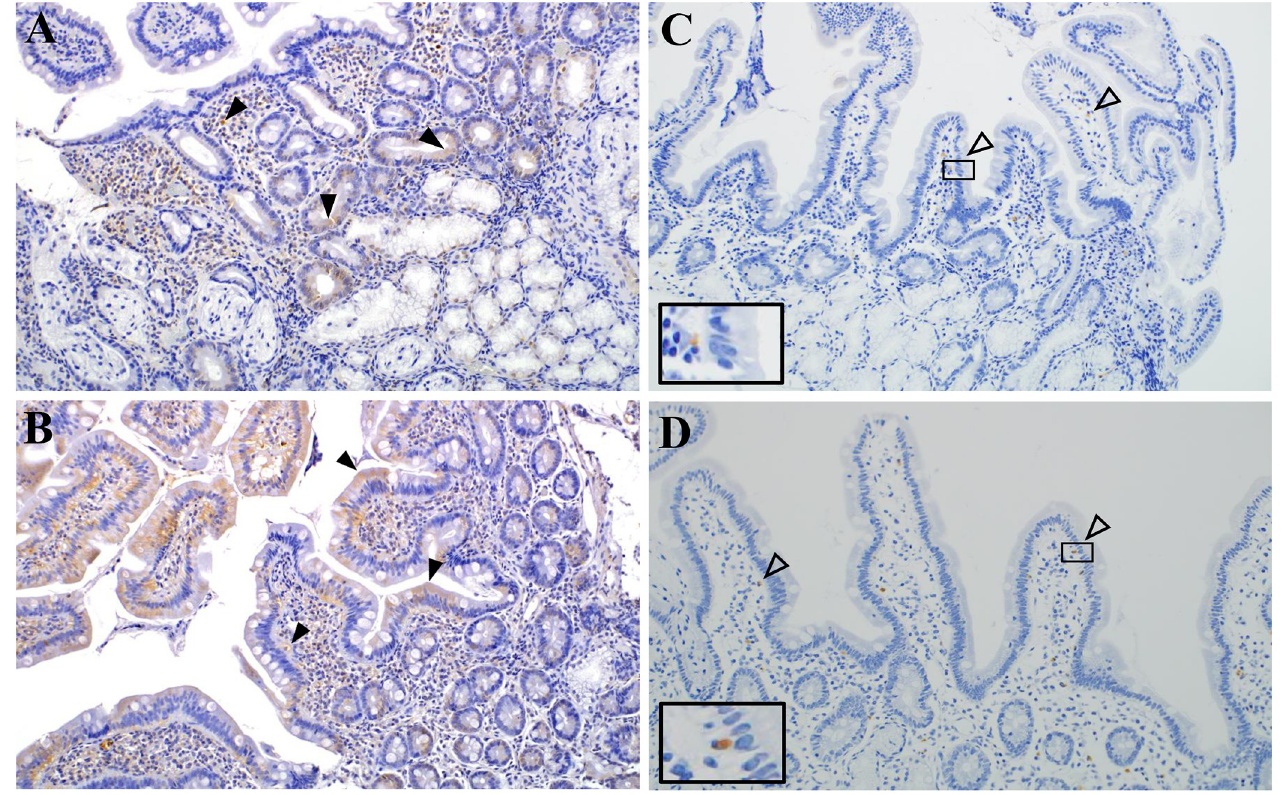
Fig 8. Location of PAR2 expression in the duodenum of patients of FD-P and ECP. PAR2 expression was localized in the duodenal epithelial cells and eosinophils in ECP and FD-P patients (Fig 8A and 8B). In addition, degranulated eosinophils were loacalized beneath the epithelial cells (Fig 8C and 8D) in the duodenal mucosa of patients with ECP and FD-P. Arrows ( ▼ ) showed PAR2-positive epithelial cells in the duodenum of patients with ECP and FD-P (Fig 8A and 8B, magnification: x200). Arrows ( 5 )demonstrated PRG2-positive degranulated eosinophils in the duodenum of patients with ECP and FD-P using anti- PRG2 antibody (Fig 8C and 8D, magnification: